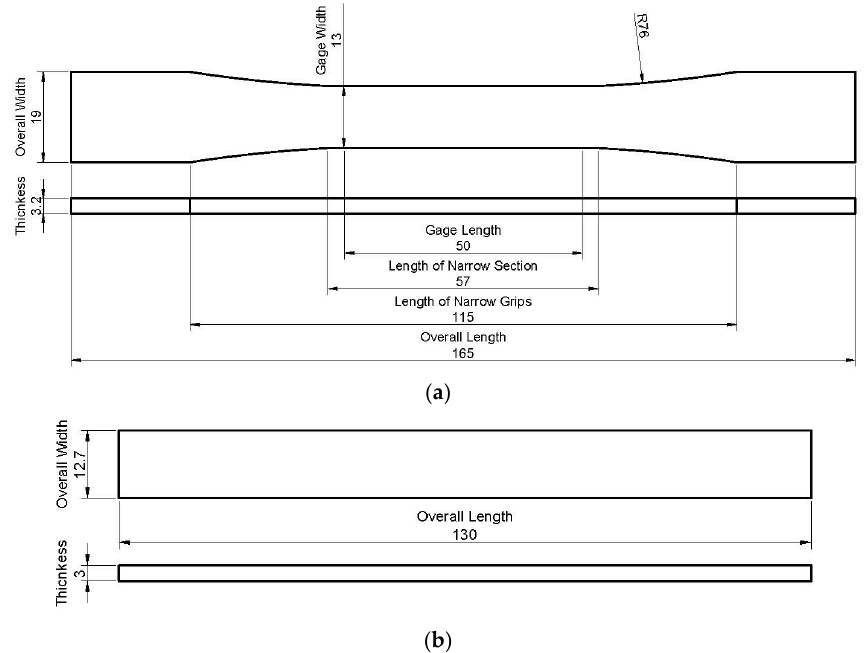
Figure 2. Dimension of samples [mm] for ( a ) tensile test; ( b ) bending test.